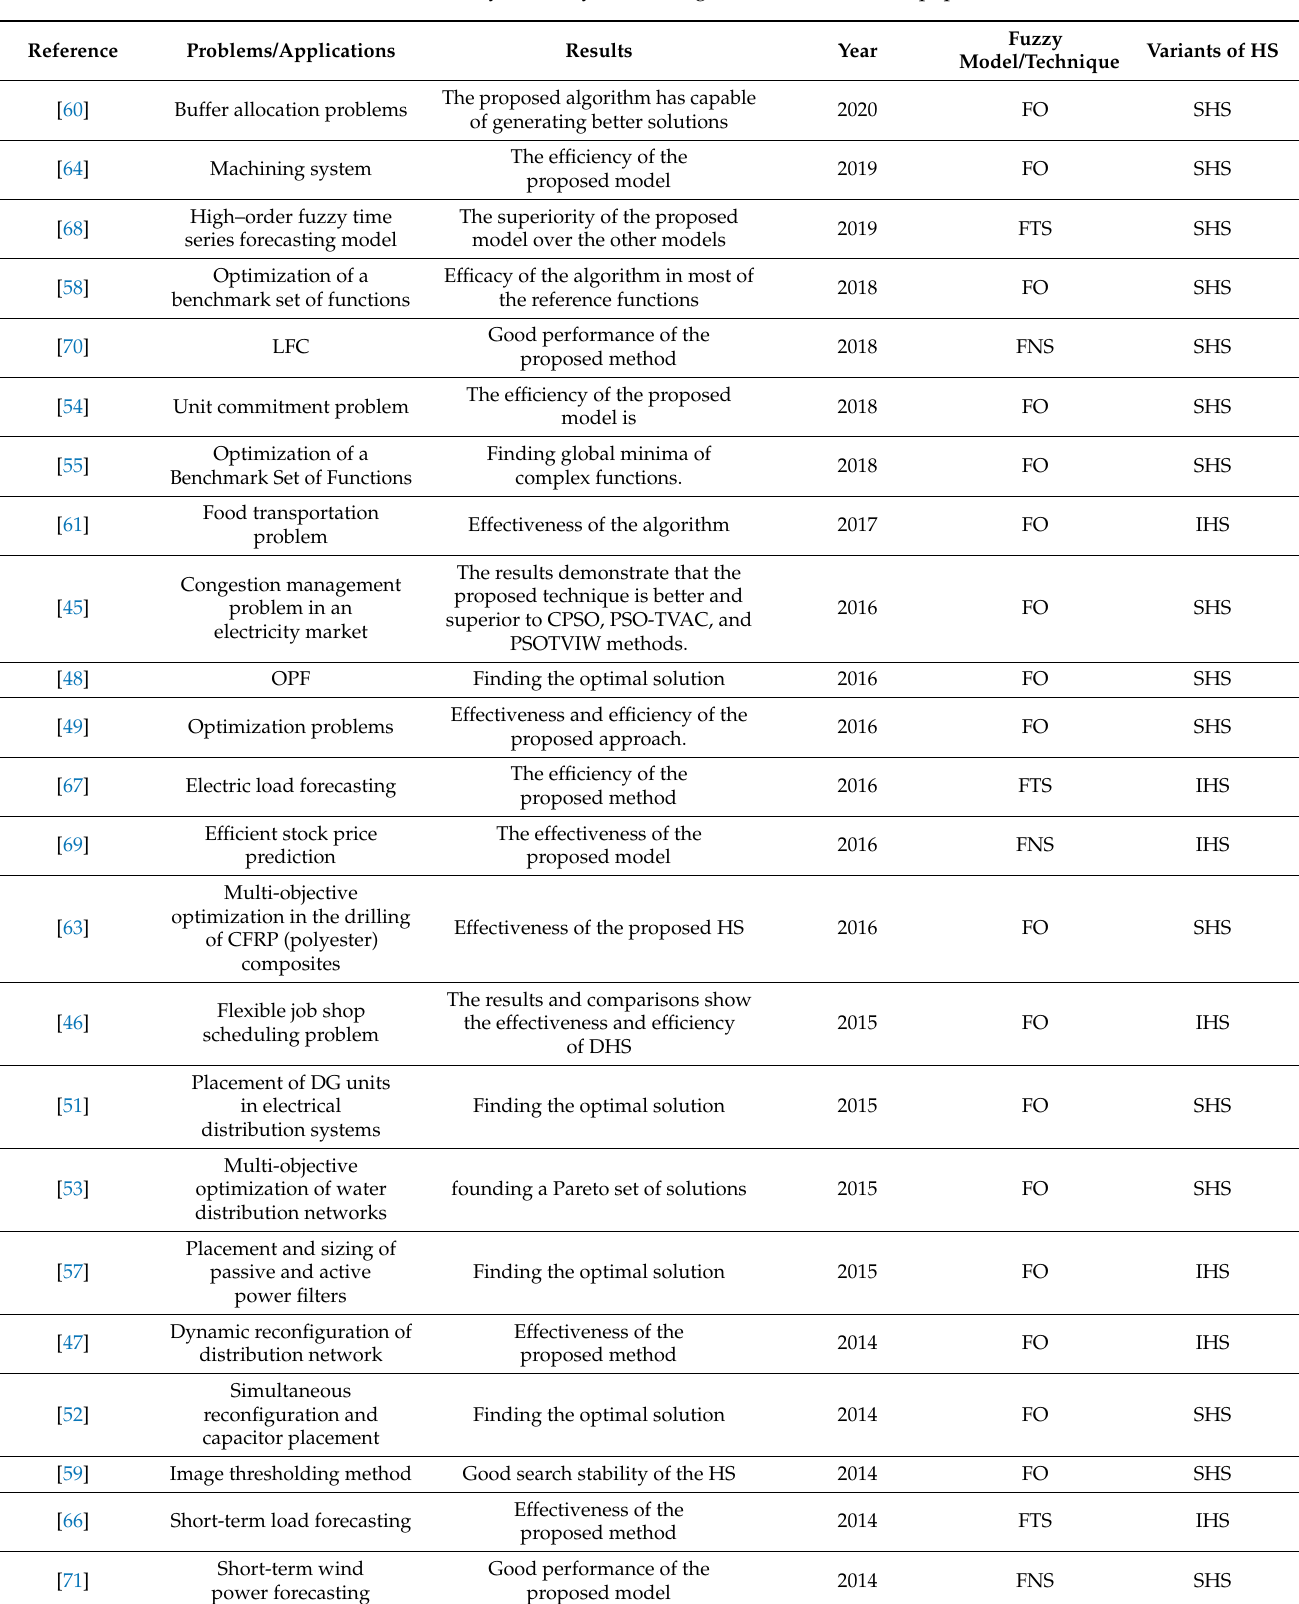
Table 1. A summary of the hybrid HS algorithm and FL based